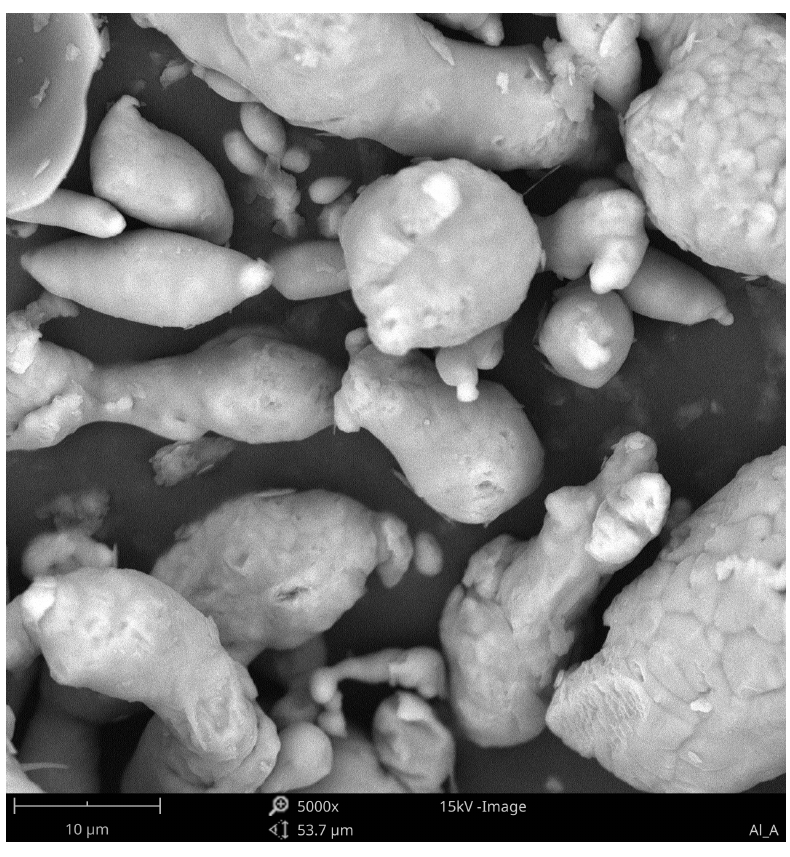
Figure A2. SEM micrograph of atomised aluminium used in this work.